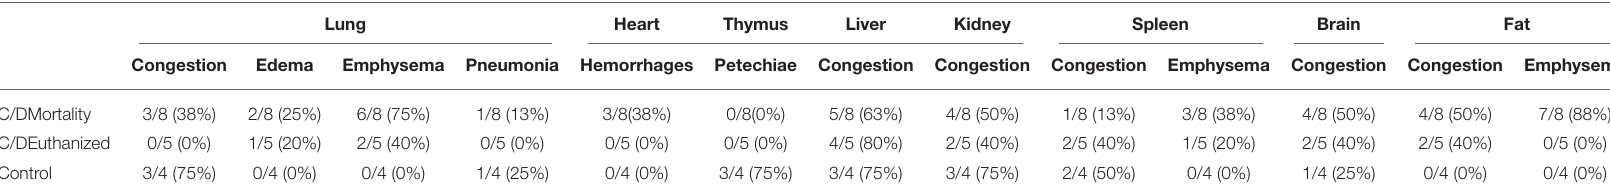
TABLE 1 | Macroscopic findings in each group of rabbits and organs.